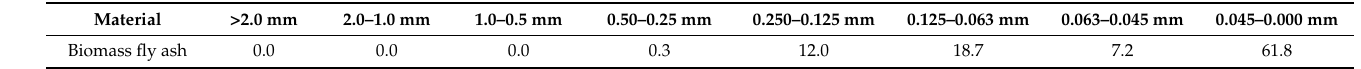
Table 4. Grain-Size Distribution of Biomass Fly Ash (%).